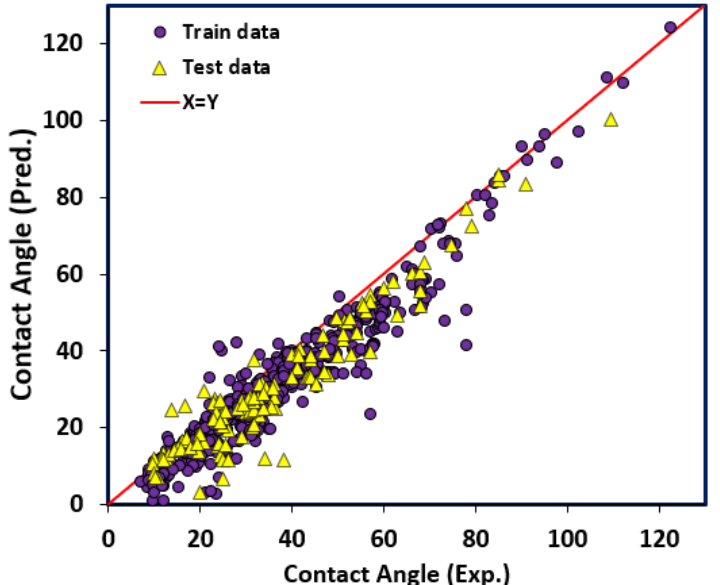
Figure 7. Predicted versus experimental contact angle.